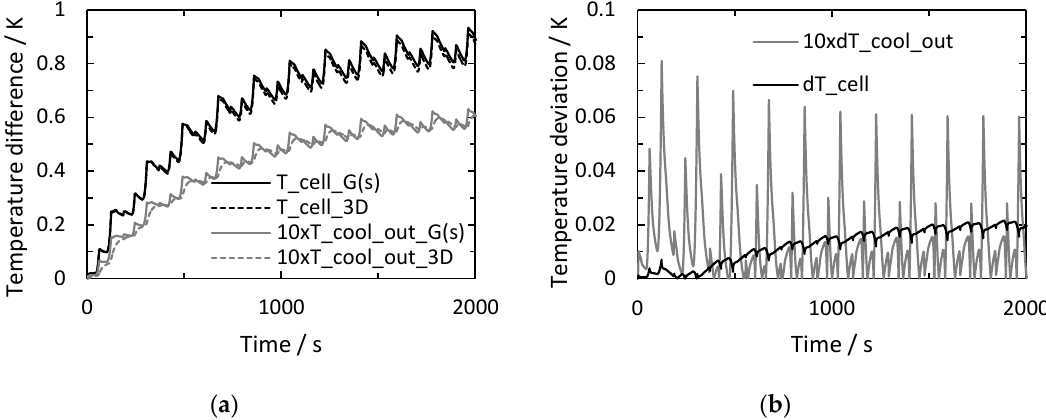
Figure 8. Trajectory of cell and coolant outlet temperature for 3D and transfer function calculation. Input is the SORT2 driving cycle. Coolant temperature is shown for ten modules in a row ( a ). Temperature deviation between 3D and transfer function calculation ( b ). The temperature difference refers to the initial conditions.